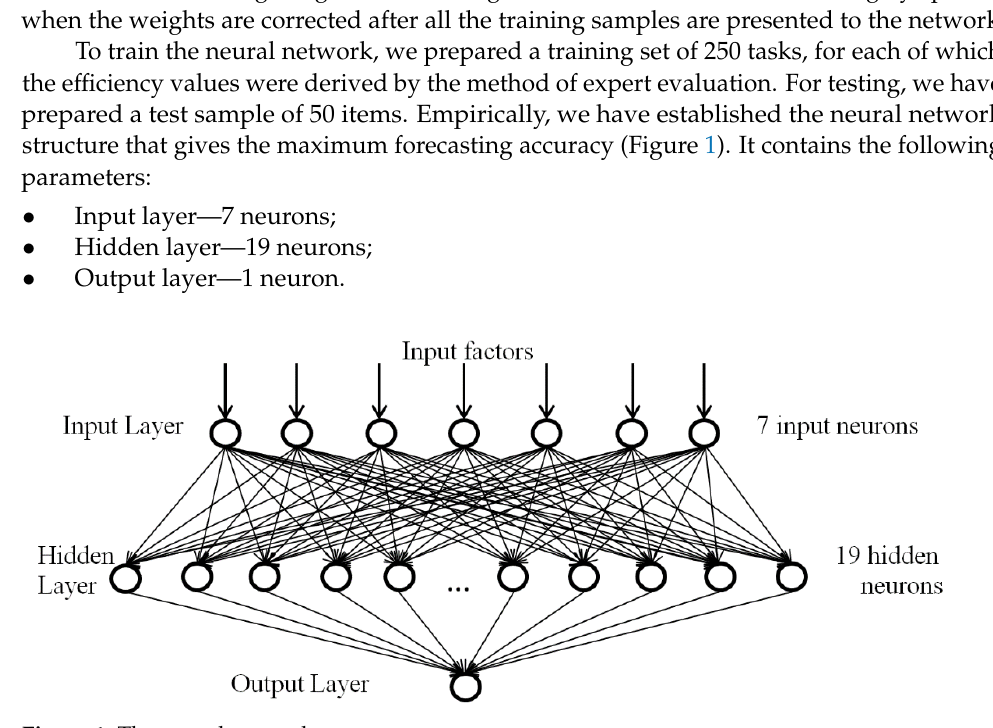
Figure 1. The neural network